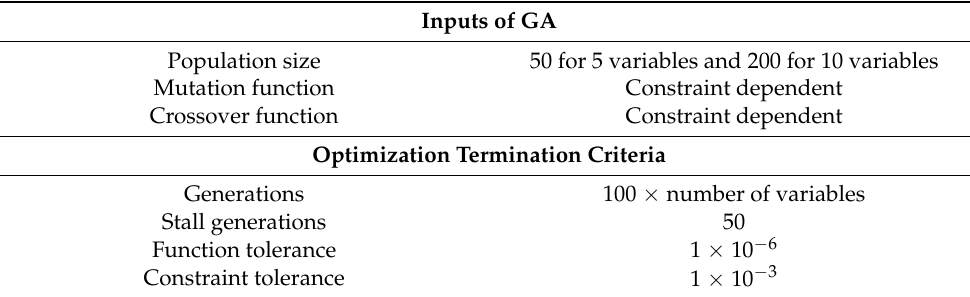
Table 4. Inputs and termination criteria.